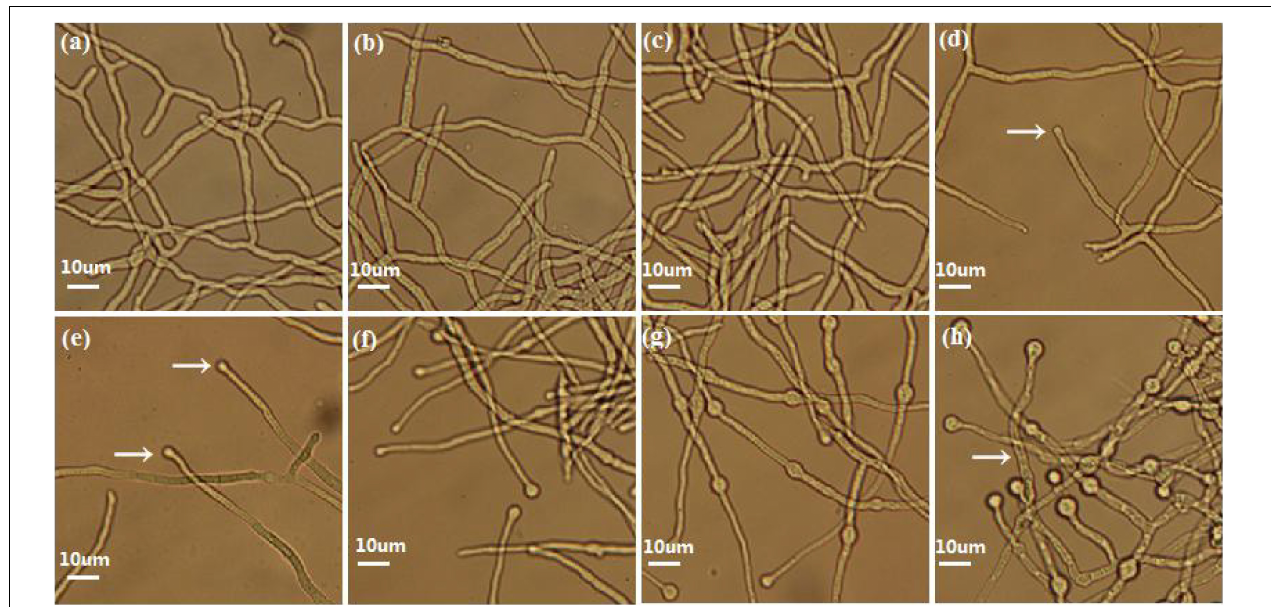
FIGURE 1 | Phenotype of CF at different stages in Trichoderma virens GV29-8. No chlamydospores were produced in TVS1 (20 h), TVS2 (24 h) and TVS3 (26 h) as shown in pictures (a) , (b) , and (c) , respectively. (d) Chlamydospores production in mycelium tips began at TVS4 (28 h) (arrow). (e) Chlamydospores began to appear on the tips of a small number of mycelia in TVS5 (32 h) (arrow). (f) About half of the mycelium tips produced chlamydospores in TVS6 (38 h). (g) Almost all mycelium tips produced chlamydospores and a lot of internal chlamydospore production was also observed in TVS7 (45 h). (h) Mycelia began autolysis in TVS8 (56 h) (arrow). Scale bars = 10 µ m.